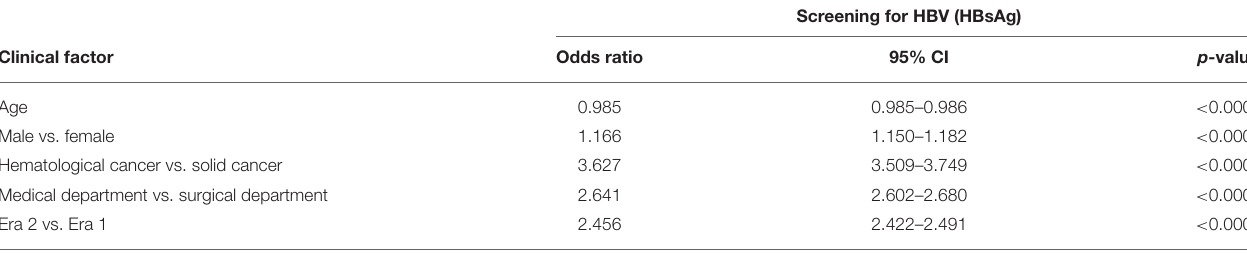
TABLE 4 | Factors related to HBV screening before cancer